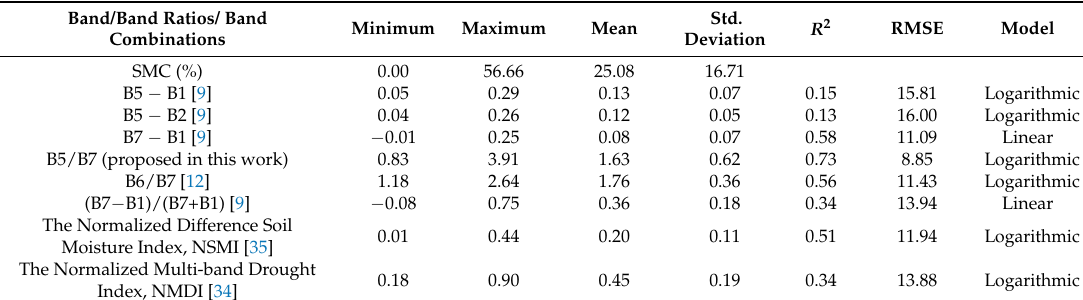
Table 4. Performance of the band, band ratios, and the combinations used for estimating SMC, using the dataset of SMC and R rs ( λ ) corresponding to the L8 bands of 80 soil sub-samples taken from the central region of